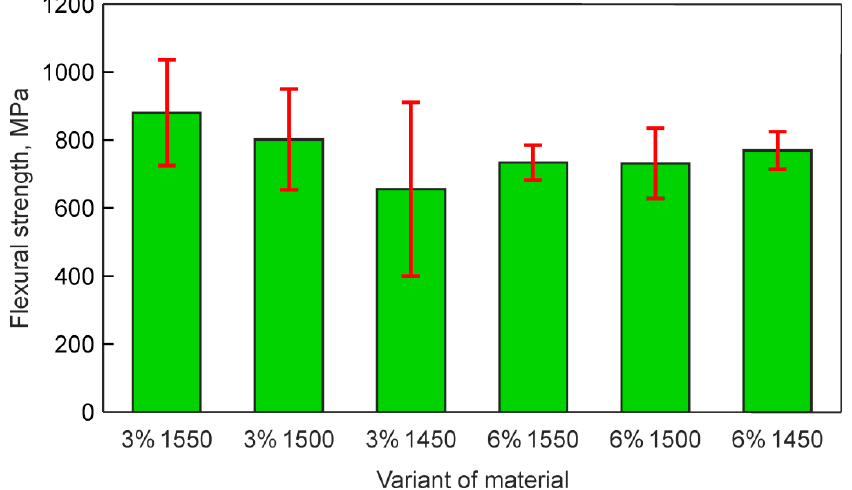
Figure 7. Flexural strength of 3YSZ and 6YSZ ceramics sintered at three temperatures.